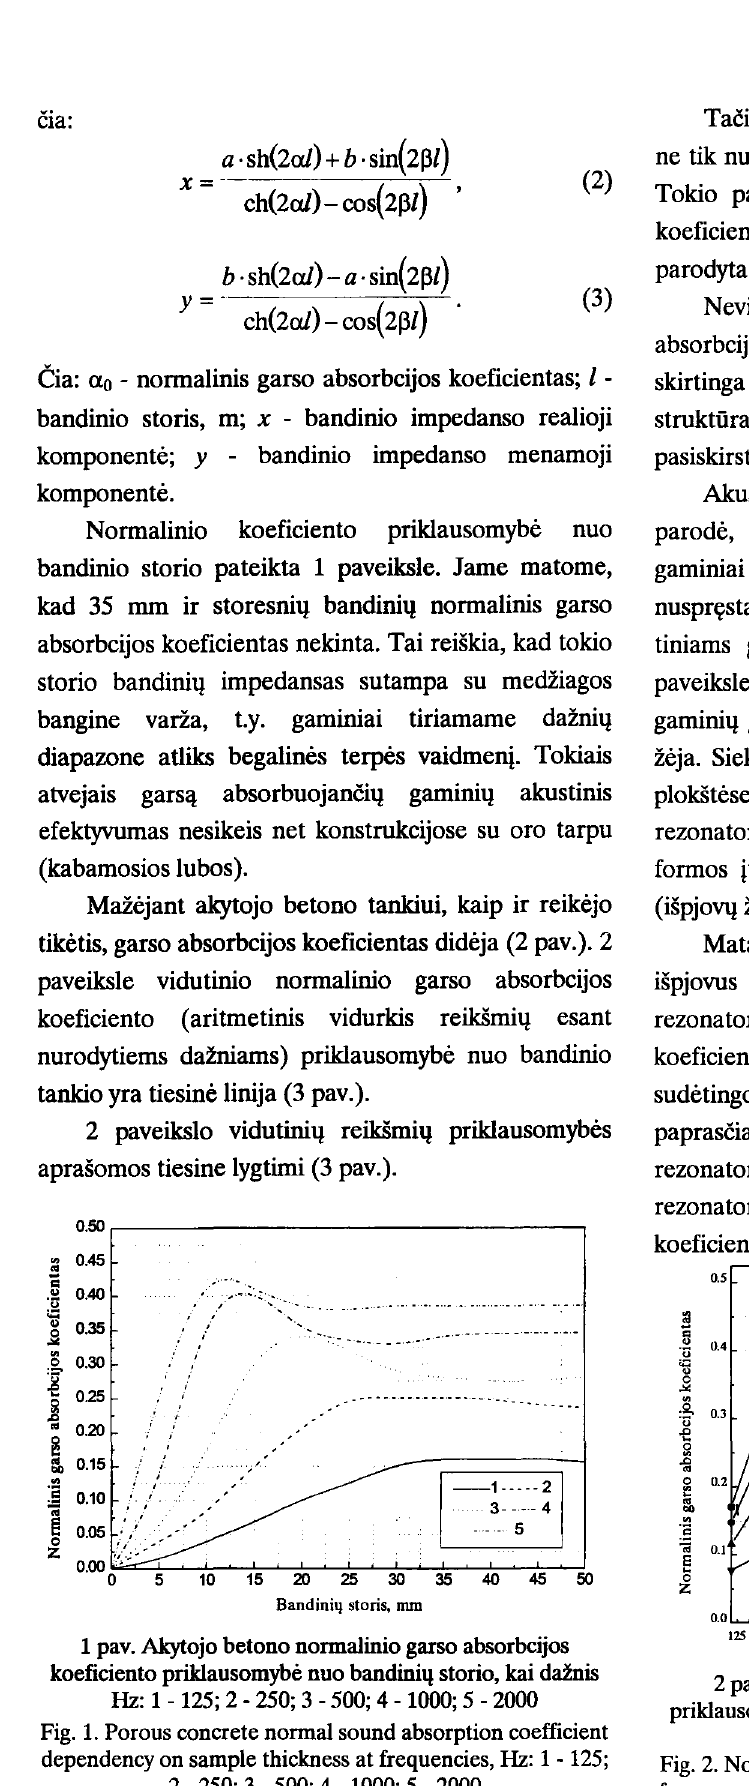
frequency at cellular silicate density, kg!m 3 : 1 - 280; 2 - 380; 3- 470; 4-